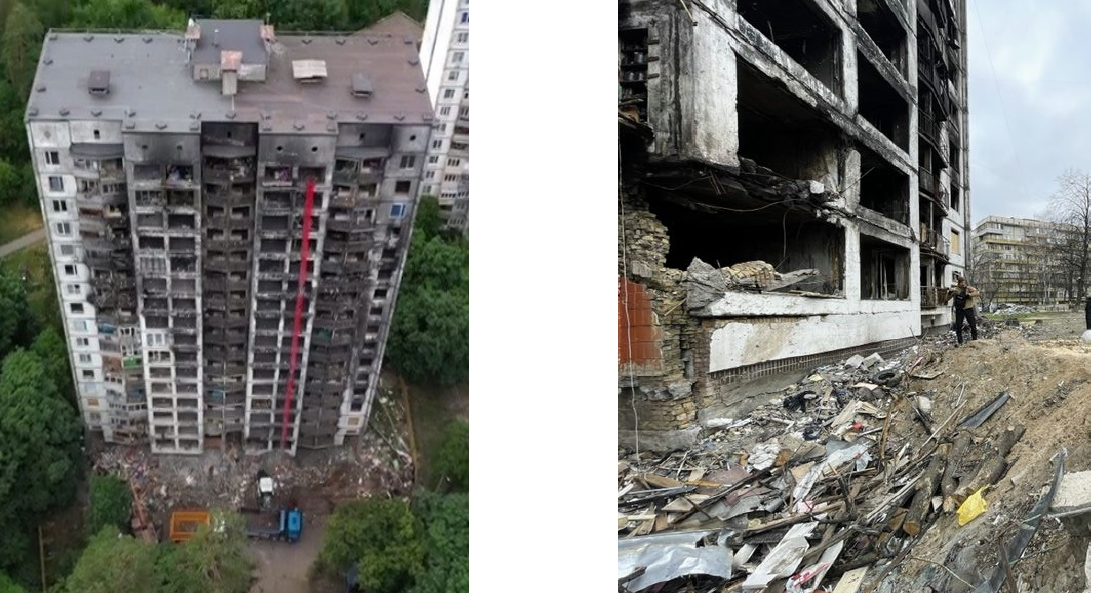
Figure 5. Damage to the multi-apartment large-panel building of the BPS series on Chornobylska Street, Kyiv city [13].